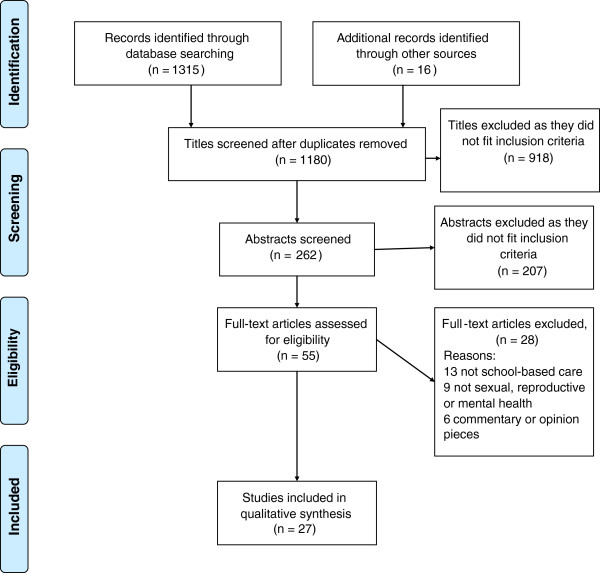
Study flow diagram.